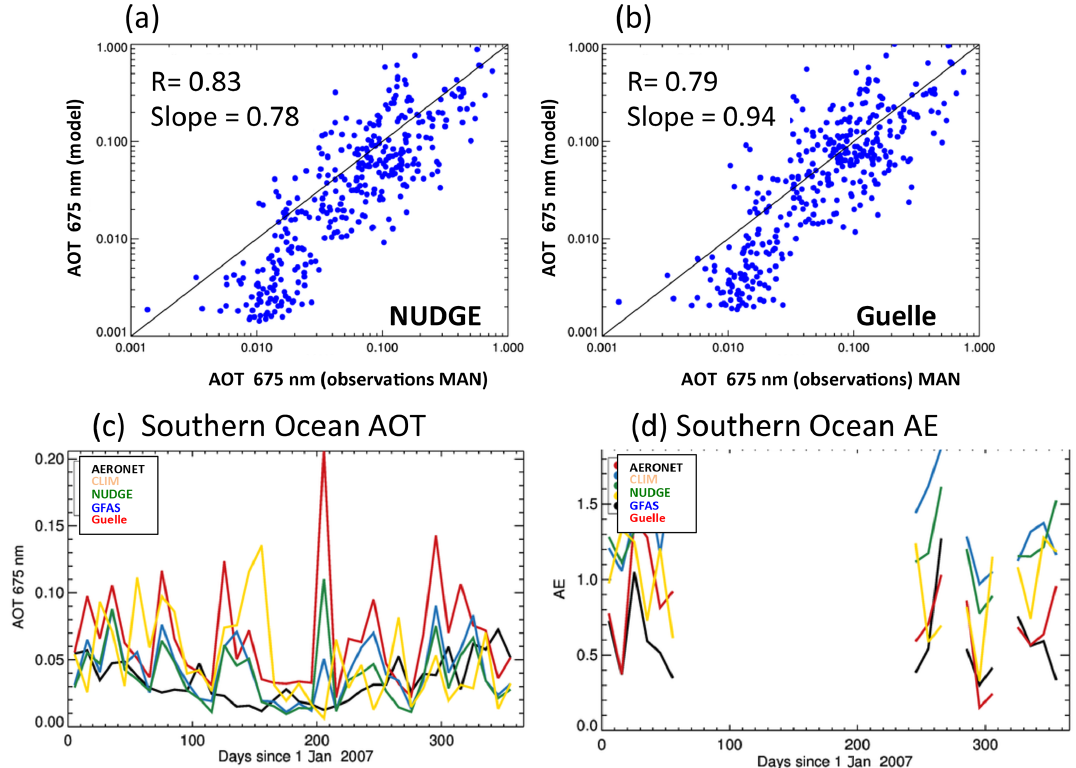
Figure 22. Comparison of model results with sun photometer data for (a) AOT at stations of the AERONET Maritime Aerosol Network for NUDGE simulations (2007); (b) as (a) for simulations with the Guelle sea salt emission parameterization; (c) time series for 2007 comparing AOT from AERONET stations for NUDGE, CLIM, GFAS, and Guelle simulations in the Southern Ocean; (d) as (c) for